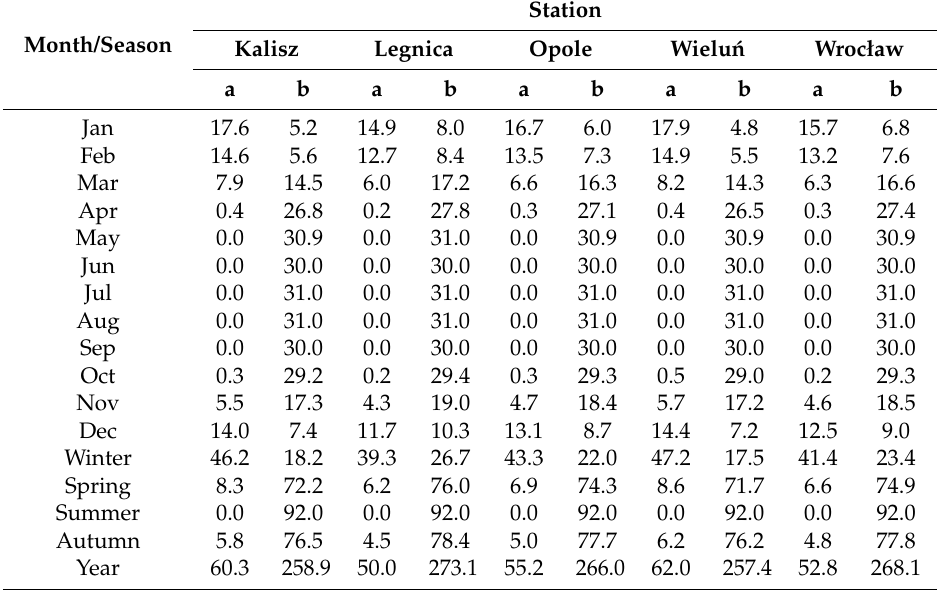
Table 7. Number of days with air temperature (Ta) charaterizing agricultural thermal periods: